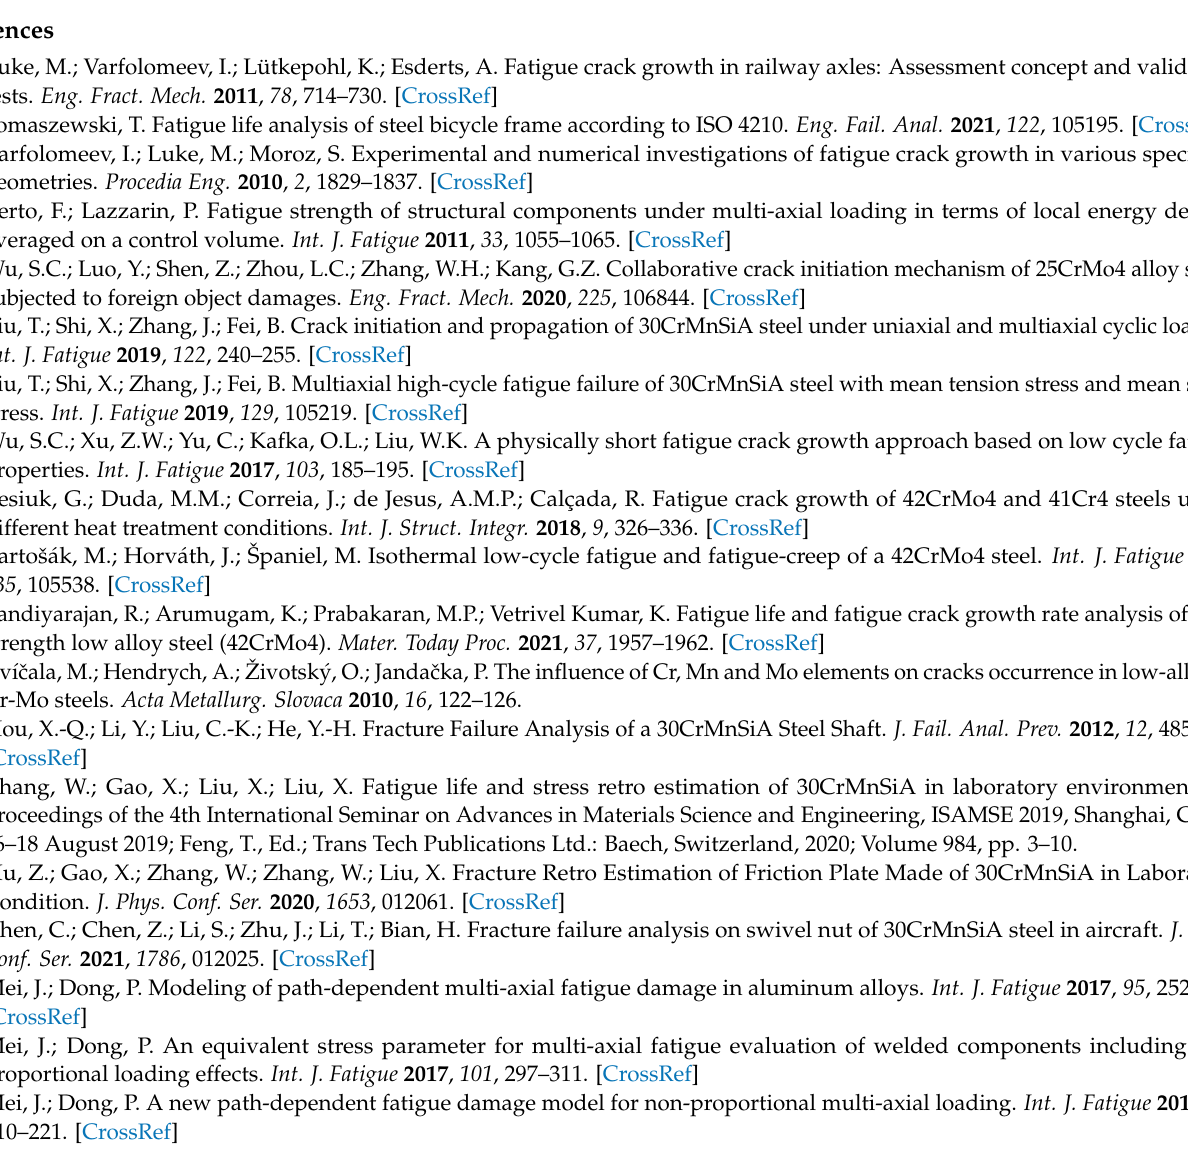
Figure A8. The procedure and results of WB method for reversal extraction under LP-2.